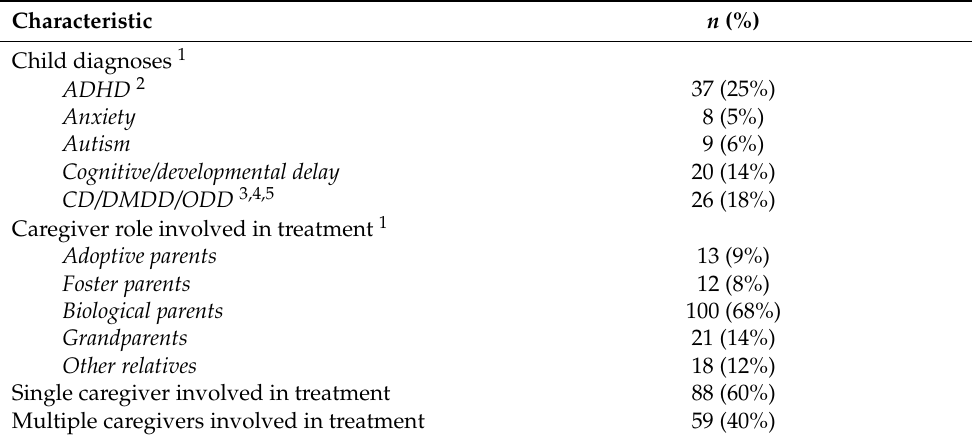
Table 3. Characteristics of Therapist Participants ( n =